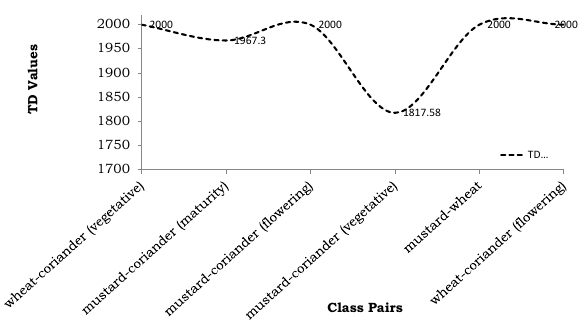
Figure 10. Transformed Divergence Analysis between different class pairs as shown in image 9.2.2017